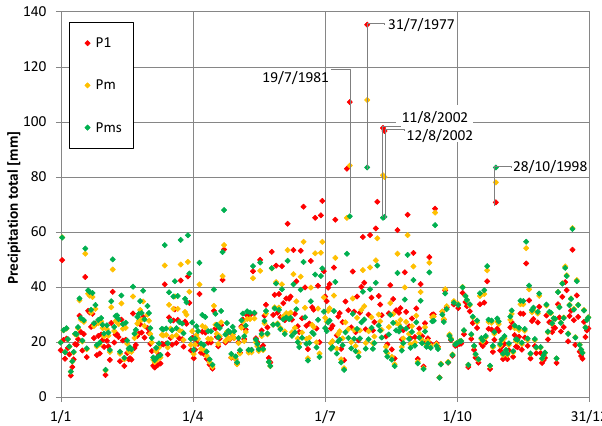
Figure 4. Daily precipitation maxima on individual calendar days at Churáˇnov station during the 1961–2010 period: non-standardized totals ( P 1 ), totals standardized for the mean and variance only ( P m = PP d /µ dG ) and fully standardized totals ( P ms ). Dates of sig- nificant totals are indicated